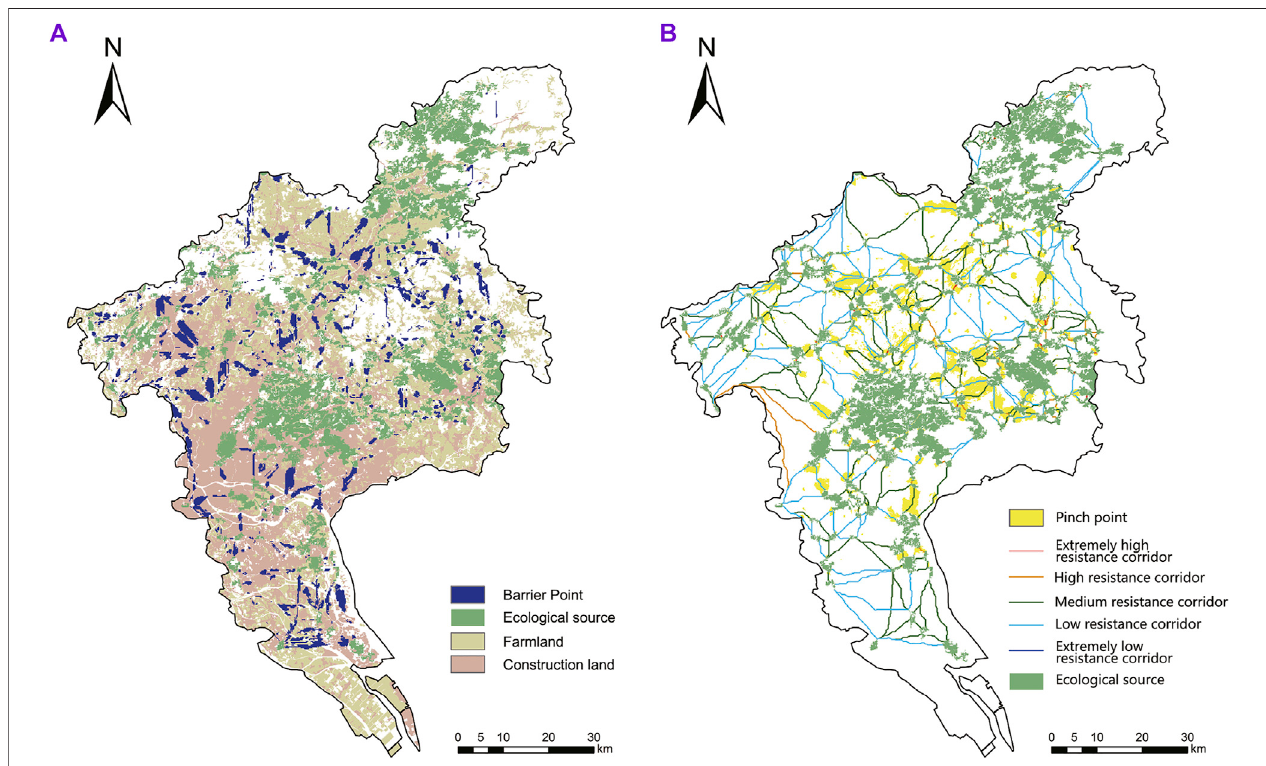
FIGURE 8 | (A) is ecological barrier point, (B) is ecological pinch